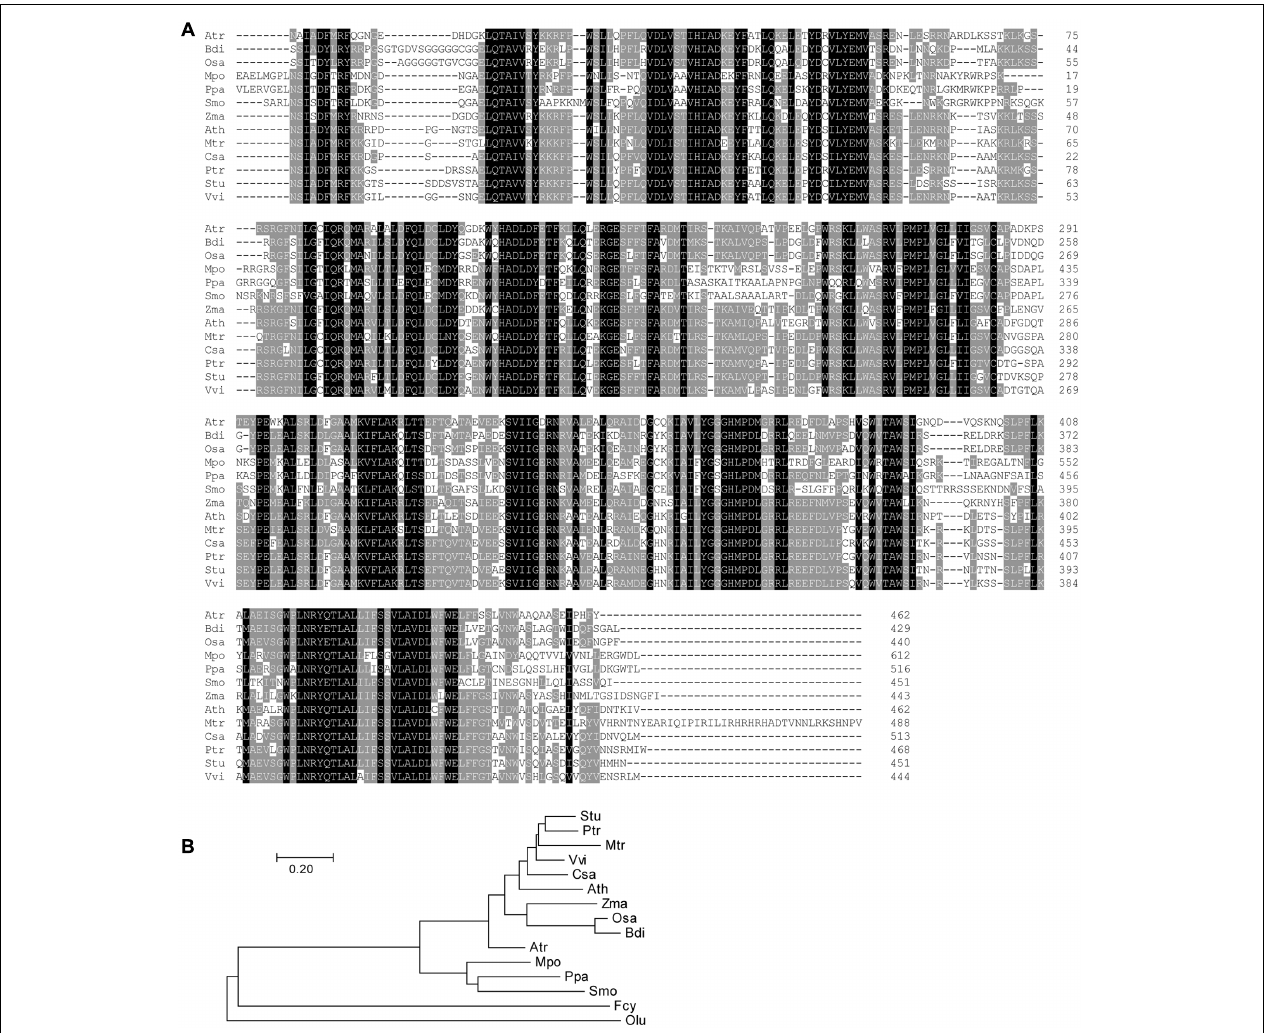
FIGURE 2 | Multiple sequence alignment (A) and phylogenetic analysis (B) of DY1 homologs. Sequences are from plant species for which full genomes have been sequenced, including Amborella trichopoda (Atr, XP_006833290.3), Arabidopsis thaliana (Ath, OAO95398.1), Brachypodium distachyon (Bdi, XP_003574414.1), Cucumis sativus (Csa, XP_004150055.2), Marchantia polymorpha (Mpo, OAE23078.1), Medicago truncatula (Mtr, AFK48173.1), Oryza sativa (Osa, XP_015650923.1), Physcomitrella patens (Ppa, XP_001768011.1), Populus trichocarpa (Ptr, XP_002324991.1), Selaginella moellendorffii (Smo, XP_002961080.1), Solanum tuberosum (Stu, XP_006353458.1), Vitis vinifera (Vvi, XP_002280972.1), Zostera marina (Zma, KMZ73824.1). Sequences from the green alga Ostreococcus lucimarinus (Olu, XP_001420303.1) and the diatom Fragilariopsis cylindrus (Fcy, OEU12403.1) which showed similarities with DY1 were incorporated in the phylogenetic tree. The scale bar corresponds to 20% amino acid sequence